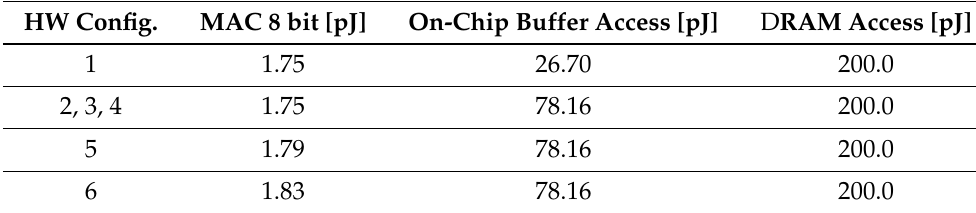
Table 4. Energy costs for each hardware configuration. HW